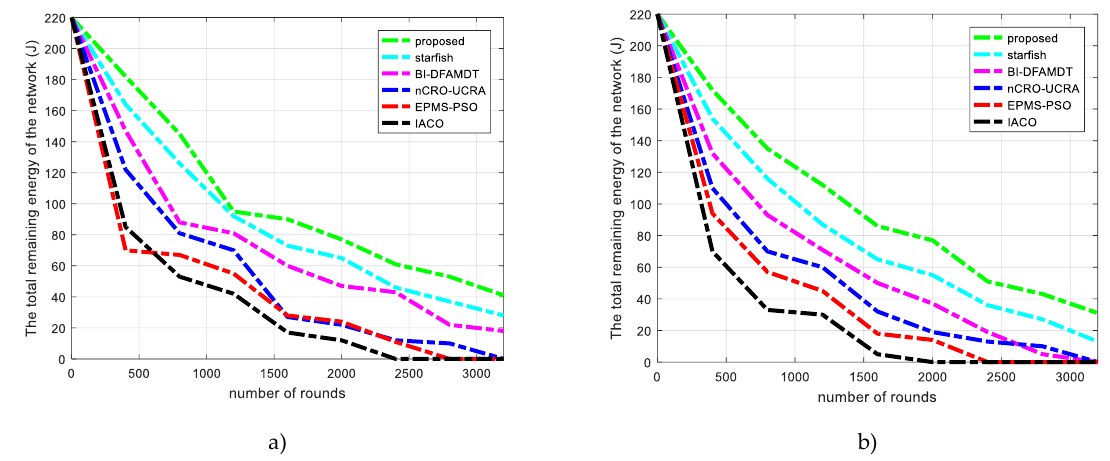
Figure 12. Comparison of the proposed scheme with existing algorithms versus total remaining energy of the network: a) Simulation graph for scenario 1; and, b) Simulation graph for scenario 2.